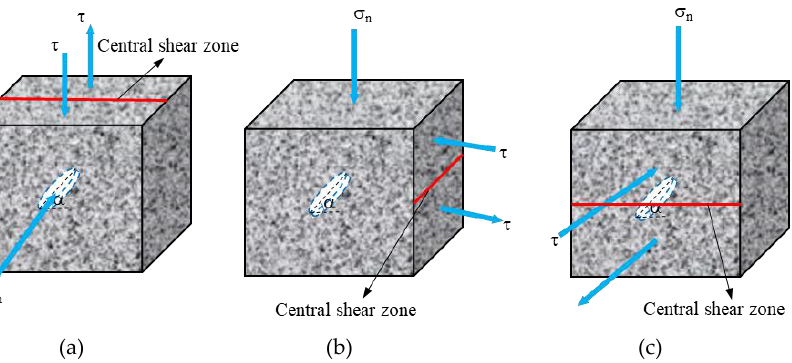
Figure 5. Schematic diagram of a sample with flaw shear in three different directions (taking an angle α = 45° as an example) : ( a ) Positive shear; ( b ) Reverse shear; ( c ) Lateral shear.